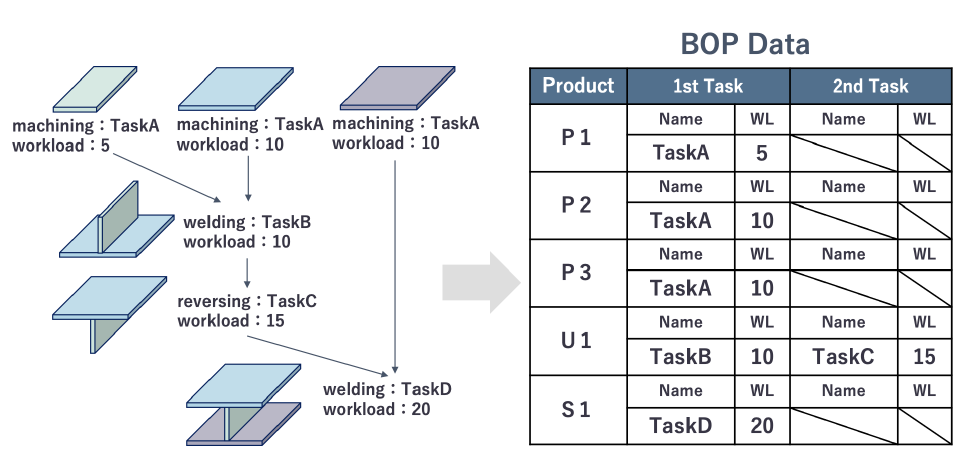
Figure 3. How to Create BOP